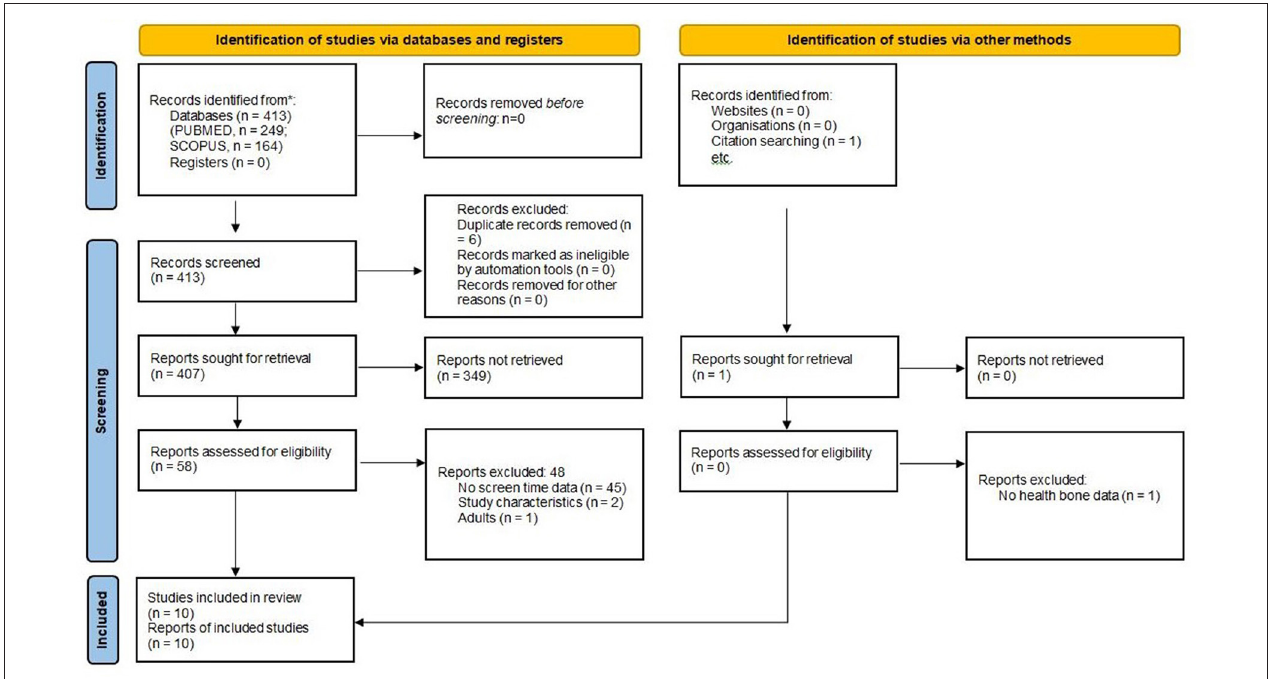
FIGURE 1 | PRISMA 2020 flow diagram for systematic reviews which included searches of databases, registers, and other sources.